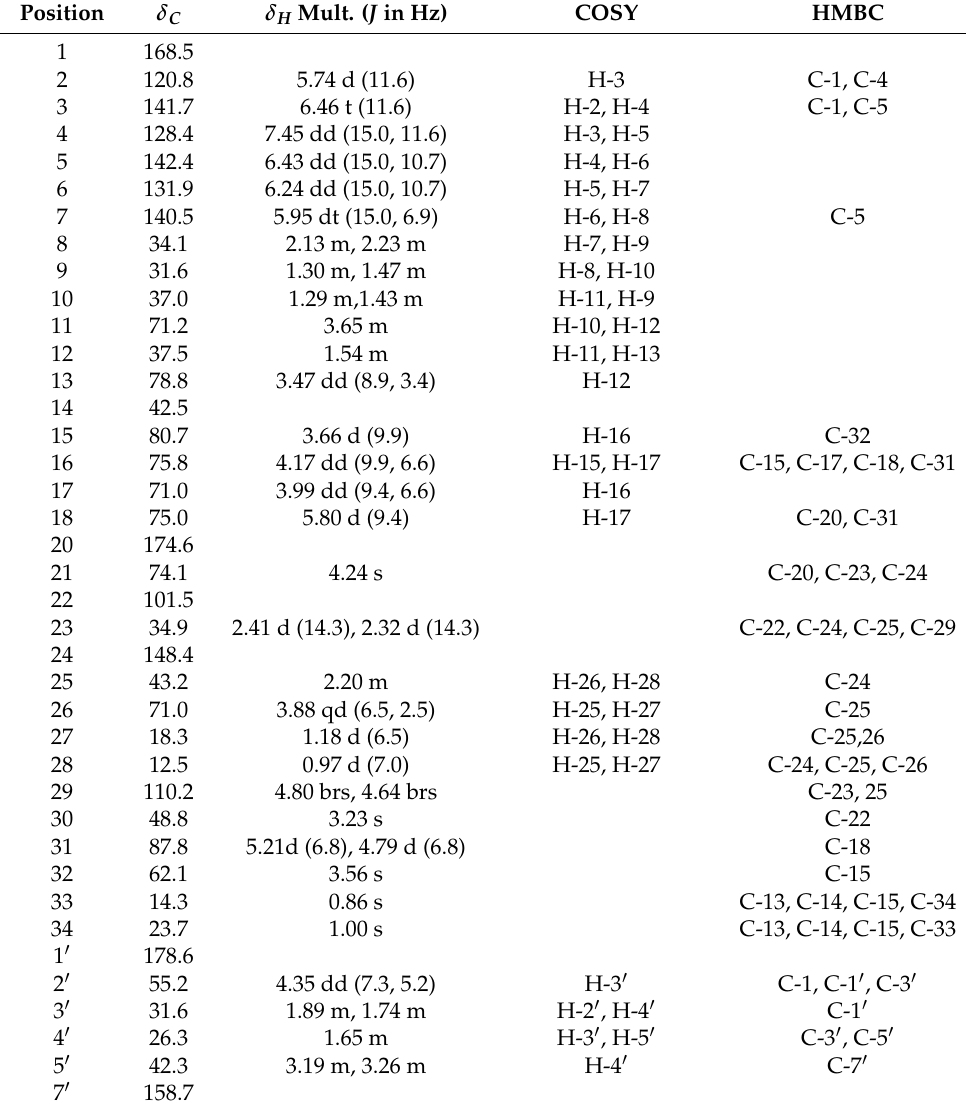
Table 1. NMR spectral data for 2 Z -onnamide ( 1 ) in CD 3 OD (400/150 MHz).